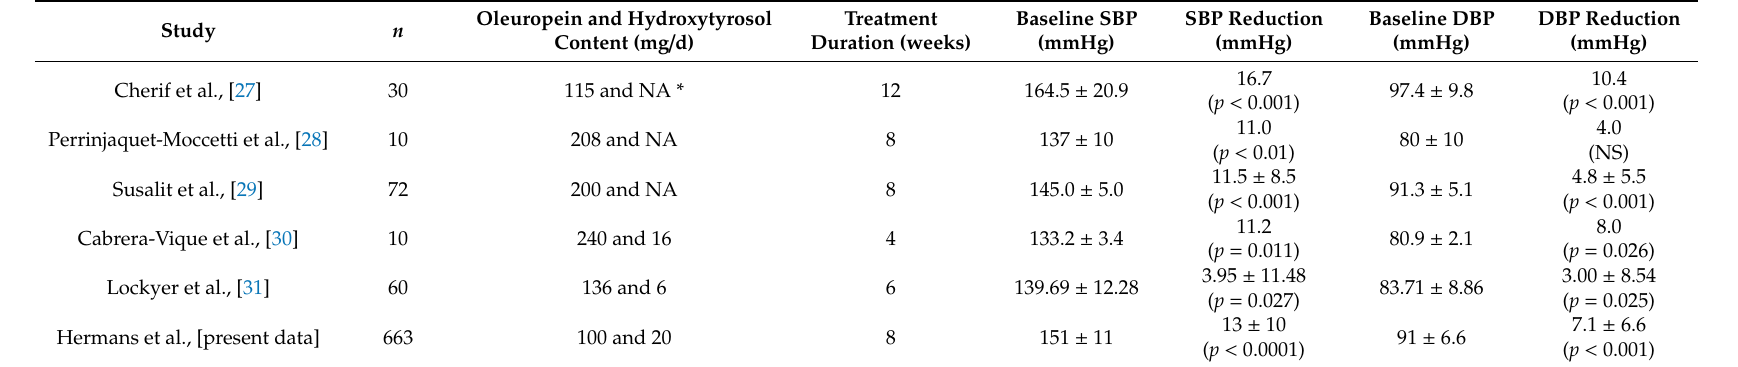
Table 5. Comparison of studies on blood pressure reduction after treatment with oleuropein and